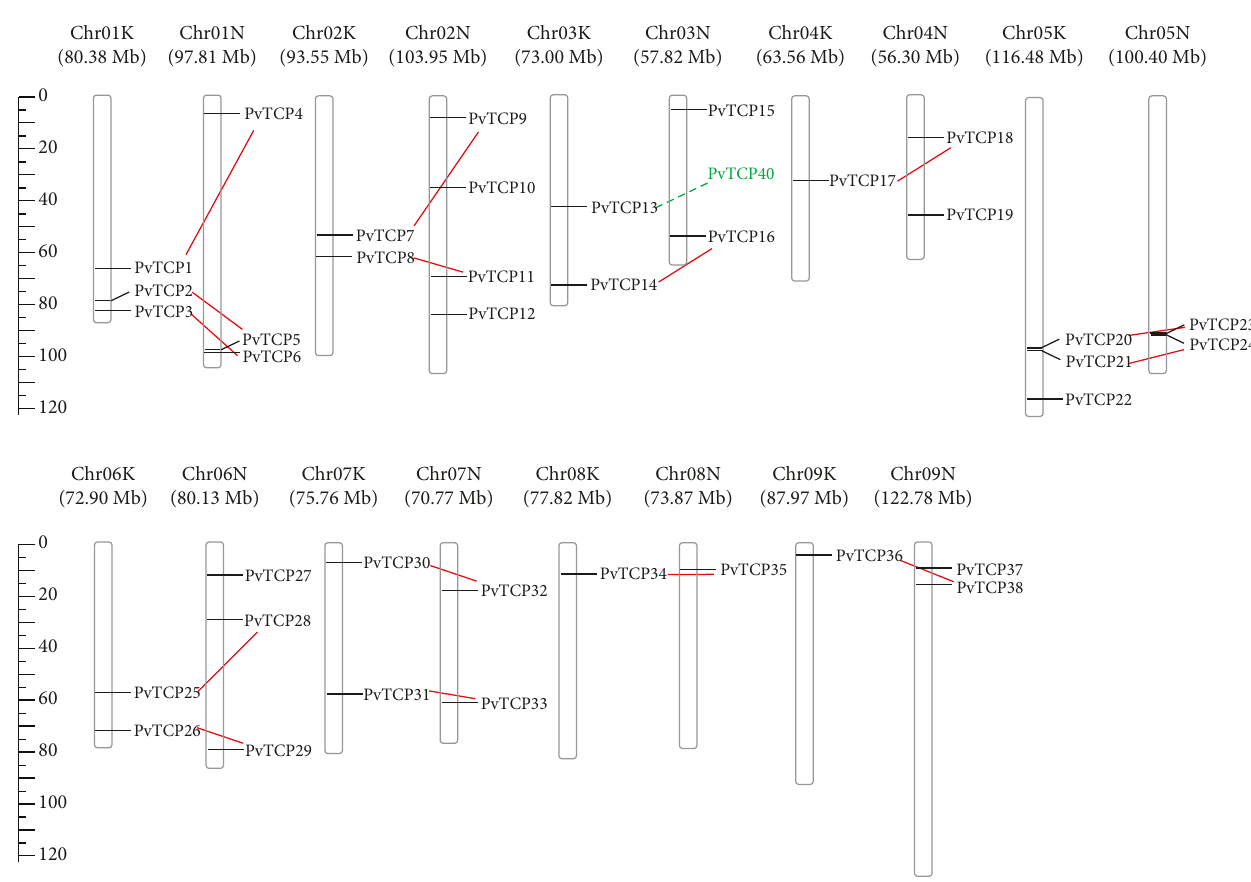
Figure 1: Chromosomal localization of switchgrass TCP genes. Chromosomal localization of PvTCPs was based on the physical map described in Phytozome v12.0. A total of 38 PvTCPs were anchored onto the chromosomes. ChrK and ChrN are two sets of subgenomes of switchgrass ( 2 n = 4 x = 36 ). The scale on the left represented the physical length of the chromosomes; Mb=million base pair. The red line represented a pair of paralogous TCP genes. The green character style represented putative gene